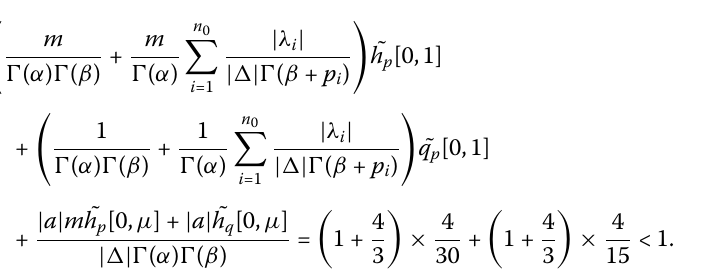
= 1, and lim ω →∞ N ( ω ) < ∞ . Note ω